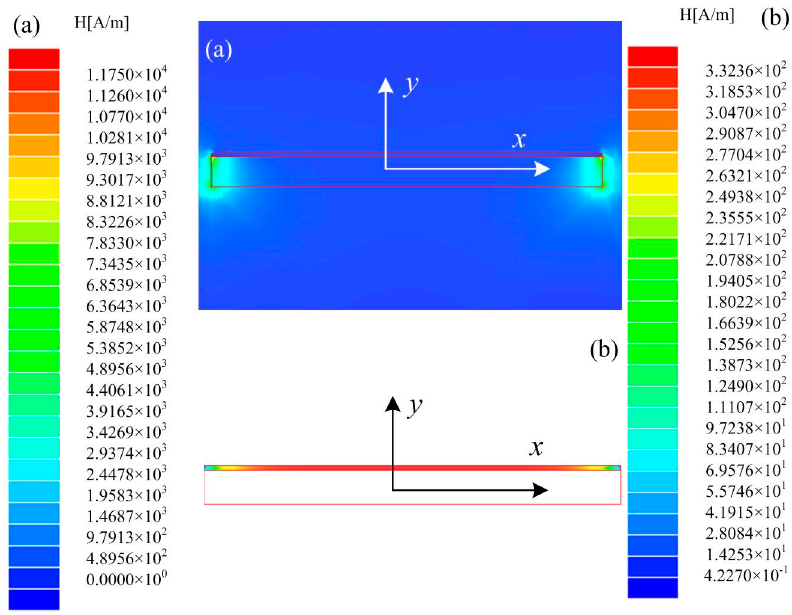
Figure 3. ( a ) The distribution diagrams of magnetic fields of the FeCuNbSiB / Ni laminate, and ( b ) The distribution diagrams of magnetic fields of the FeCuNbSiB ribbon in the FeCuNbSiB / Ni laminate.